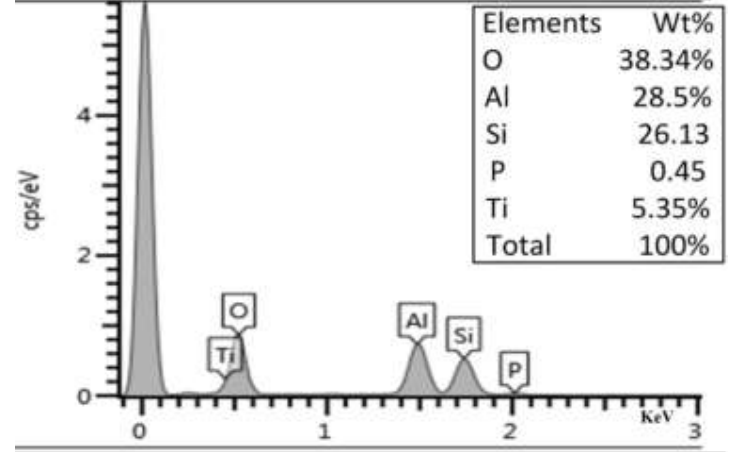
Figure 4 demonstrates the documented EDX spectrum validating the chemical compositions of the cross-segment view of AAO pattern onto Ti/Si substratum were analogous for various anodizing voltages.